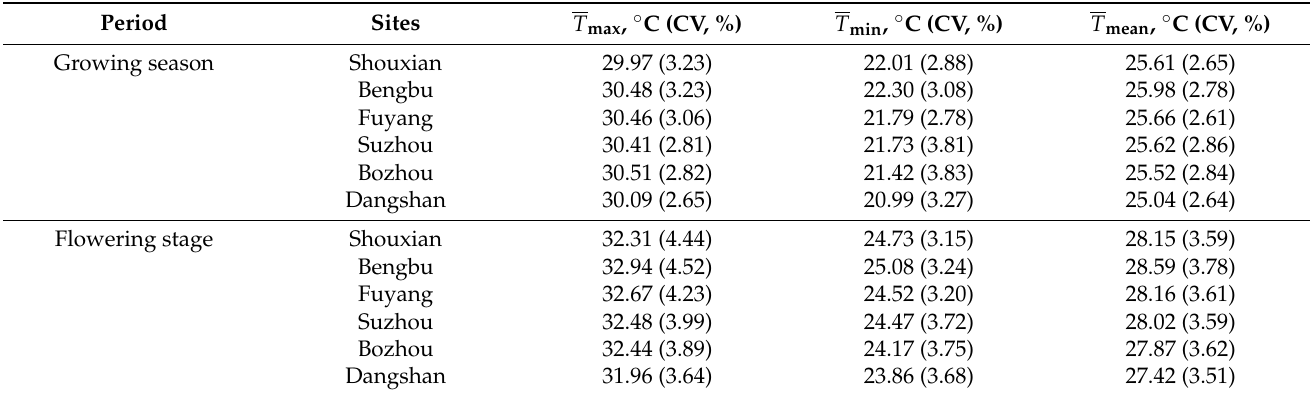
Table 2. Quantitative of characteristics of T max ( ◦ C), T min ( ◦ C) and T mean ( ◦ C) and its CV (%) value during the maize growing season and flowering stage over 61 years in six sites, i.e., Shouxian, Bengbu, Fuyang, Suzhou, Bozhou, and Dangshan.